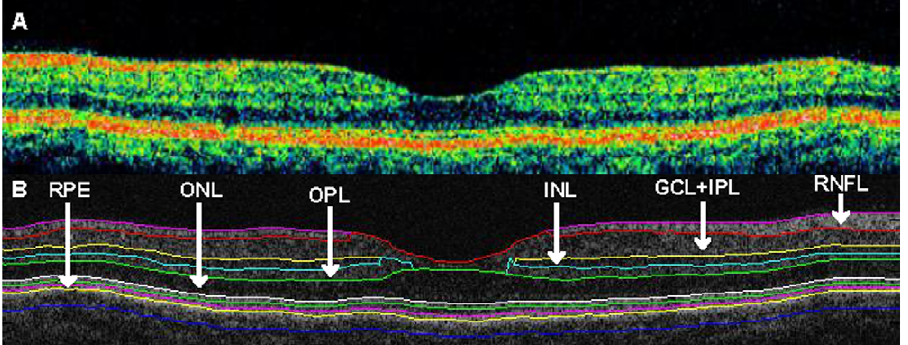
Figure 2. Macular image segmentation using OCTRIMA. The image of a healthy macula scanned by Stratus OCT. (B) The same OCT scan processed with OCTRIMA. We note the ONL segment includes the IS of photoreceptors and the external limiting membrane, which are not resolved by the Stratus OCT device. Abbreviations: GCL + IPL, ganglion cell layer and inner plexiform layer complex; INL, inner nuclear layer; ONL, outer nuclear layer; OPL, outer plexiform layer; RNFL, retinal nerve fiber layer; RPE, retinal pigment epithelium.